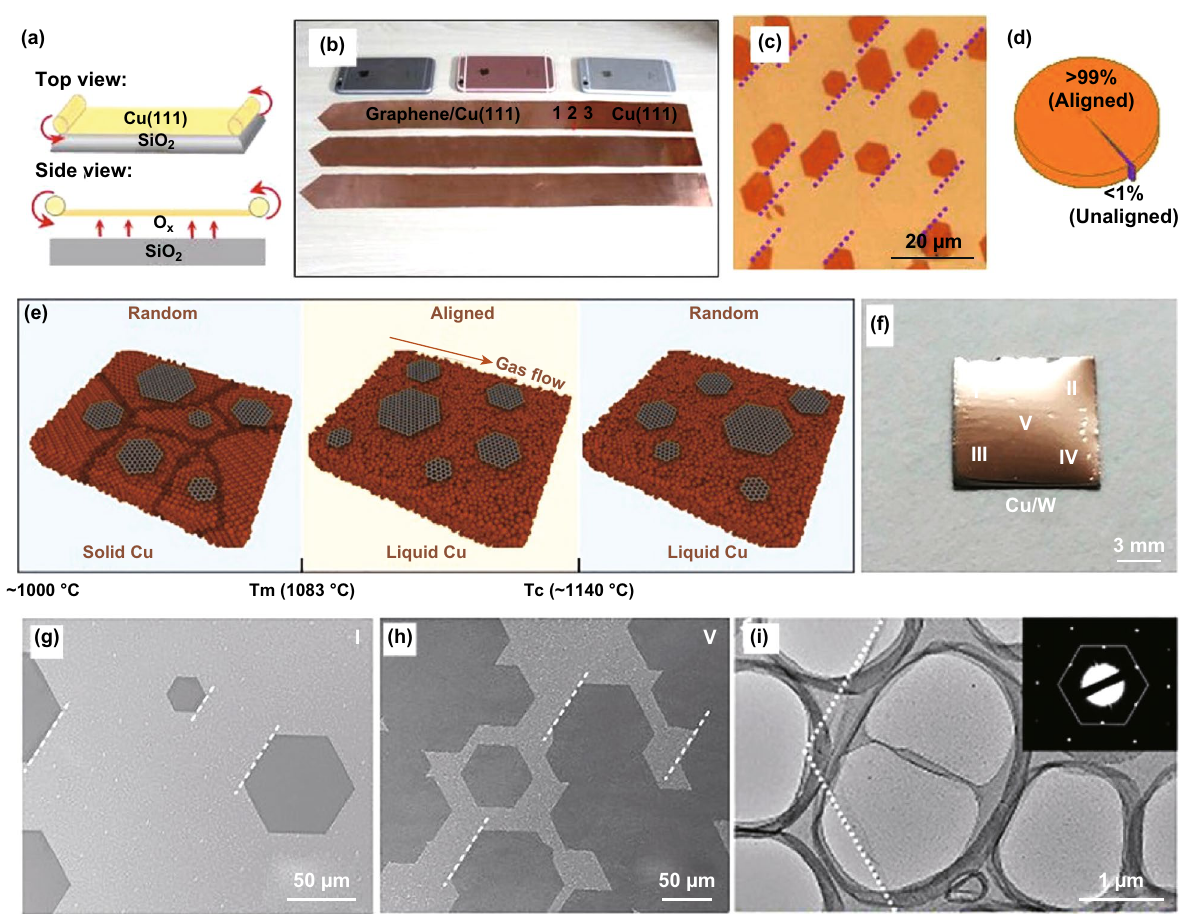
Fig. 14 Synthesis of large-area graphene. a Top and side schematic views of the continuous graphene film growth system, where the Cu (111) foil was placed above a SiO 2 substrate with a small separation, for ultrafast growth. b Cu (111) foils with graphene coverages of 60% (top), 90% (middle), and 100% (bottom), where the “shining” parts are graphene/Cu (left side). The three mobile phones are placed nearby as a reference for size. c Optical image of the arbitrarily distributed holes formed by H 2 etching of the graphene film. Edges of the holes marked by the dashed lines are parallel with each other. d The proportion of the aligned graphene islands restrained from optical images. Adapted with permission from Ref. [11]. Copyright, 2017, Elsevier. e Schematic illustration of graphene formation behaviour under different temperatures. f Photograph of a 1 × 1 cm 2 sample after graphene growth. g , h SEM images of graphene parts in different areas. i TEM image revealing high-quality single- crystal monolayer of graphene. Adapted with permission from Ref. [129]. Copyright 2019 American Chemical